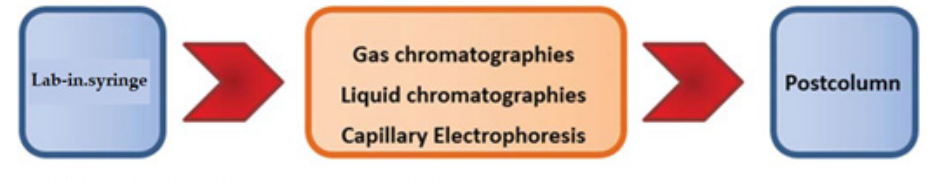
Figure 9. Hyphenation possibilities of LIS with atomic spectroscopies (spectrometries), chromatographies and using stop-flow techniques.